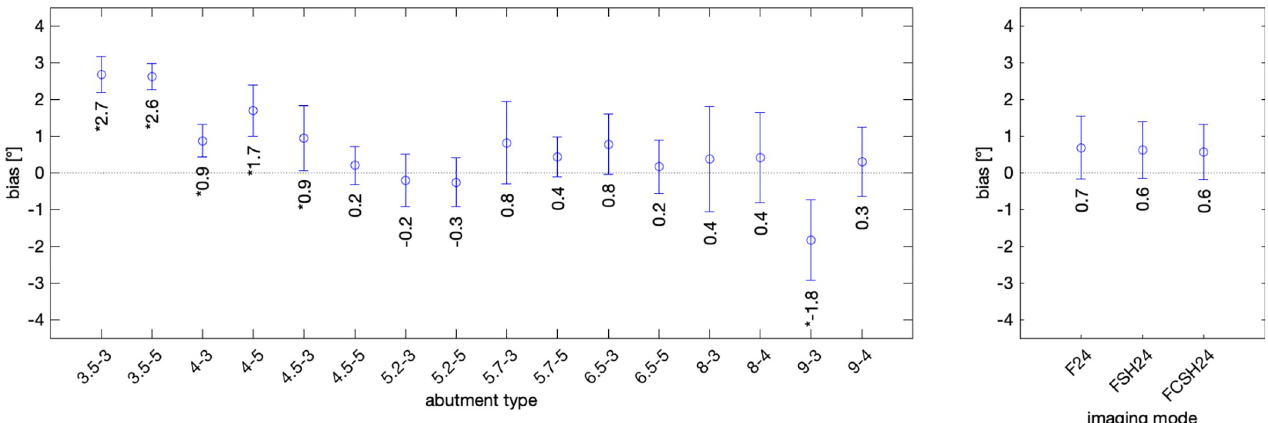
Fig 6. Bias in measuring abutment angles, for all 16 abutments. Left graph: The mean bias in degrees and confidence interval error bars across three imaging modes (F24, FSH24, FCSH24). Most of the biases, even if statistically significant, were small. Right graph: Mean bias in degrees and confidence interval error bars across 16 abutment types (3.5–3 to 9–4) for each imaging mode (F24, FSH24, and FCSH24).